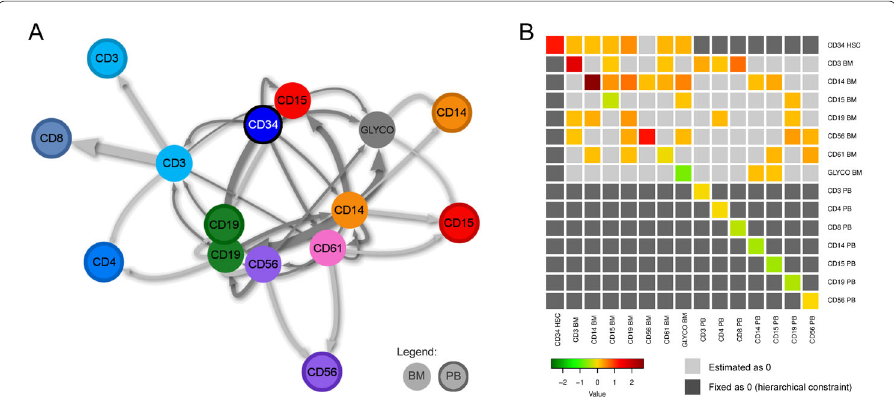
Fig. 5 Estimated (filtered) human hematopoietic differentiation process. a The network configuration of the human hematopoietic differentiation process. Nodes representing lineages positive for the surface marker and collected from bone marrow and peripheral blood (circled) have the same color. Lymphoid lineages have a blue/green color, whereas myeloid cell types are red/orange and violet. The node corresponding to the stem cell (CD34) is dark blue and circled in black. Glycophorin positive cells(Glyco) and CD61 are respectively grey and pink. Network layout has been generated with a force directed layout, excluding ≤ 0.1. b Parameters heatmap. Main diagonal elements correspond to netduplicationrate . Off-diagonal λ i , j elements correspond to differentiation rates (row → column). Light-Grey entries are differentiations rates estimated as 0 by SCAD penalization or smaller than 0.1. Dark-Grey entries are excluded from the inferential procedure due to violation of hierarchical constraints